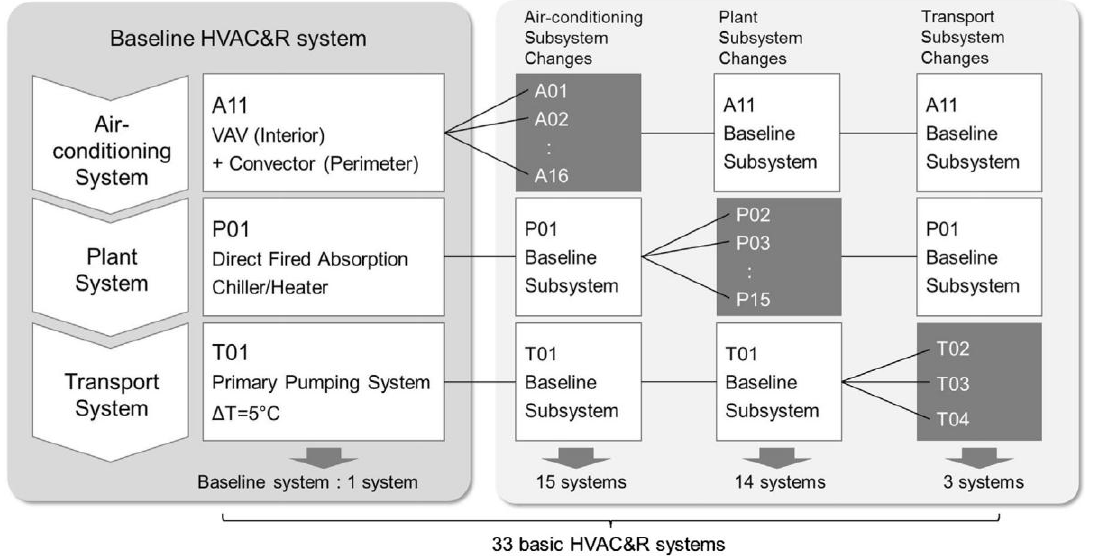
Figure 3. A Method for evaluating energy consumption of basic HVAC & R (heating, ventilating, air-conditioning, and refrigerating) set.